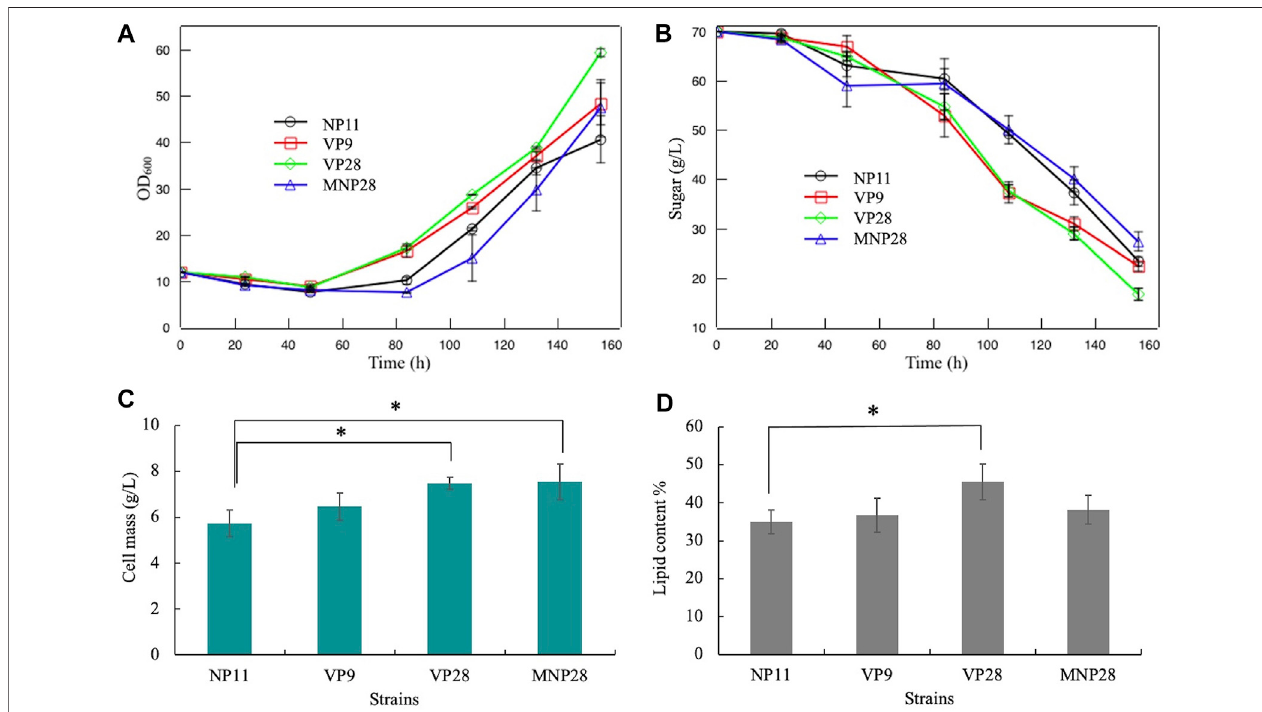
FIGURE3| Fermentationperformanceofengineeringstrainsandthecontrol: (A) cellgrowth; (B) glucoseconsumption; (C) cellmassatthefermentationendpoint; (D) lipidcontentatthefermentationendpoint.Errorbarsrepresentthestandarddeviationofthreeindependentexperiments.Signi fi cantlydifferentvalueswereperformed by the ANOVA and post hoc Dunnett test. * means p <